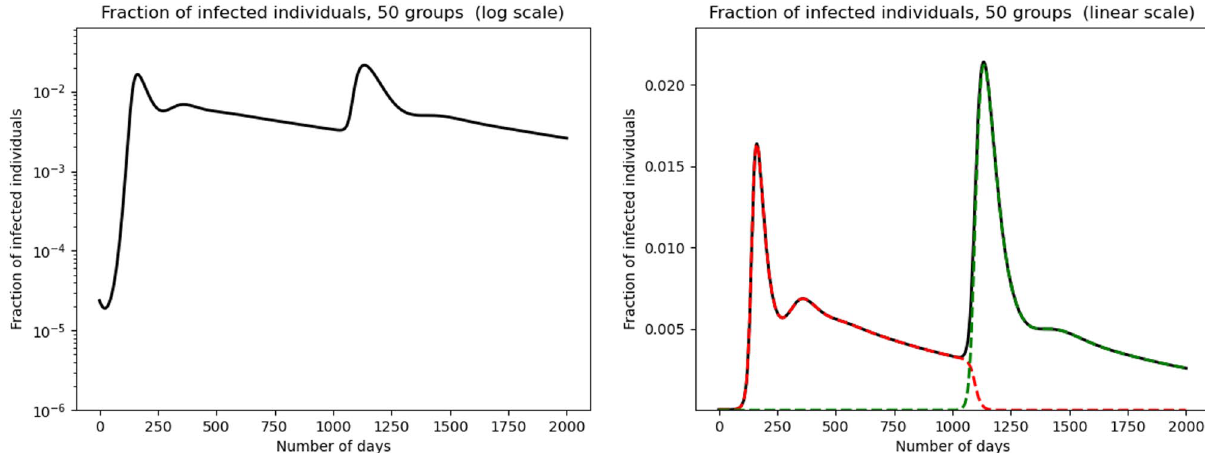
Figure 4. Multiple epidemic rebounds due to a variant virus: susceptible individuals are divided into 50 discrete groups in the case where a new variant appears at Day t = 1000 . The transmission rate β 2 is taken as β 2 ( a ) = 1.5 β 1 ( a ) , d = 0.0002 , γ 1 = 0.1 and γ 2 = 0.05 . The fraction of infected individuals in the population is represented in the left graph in logarithmic scale. The total infected population is represented in linear scale in the right graph (black curve), variant 1 in red and variant 2 in